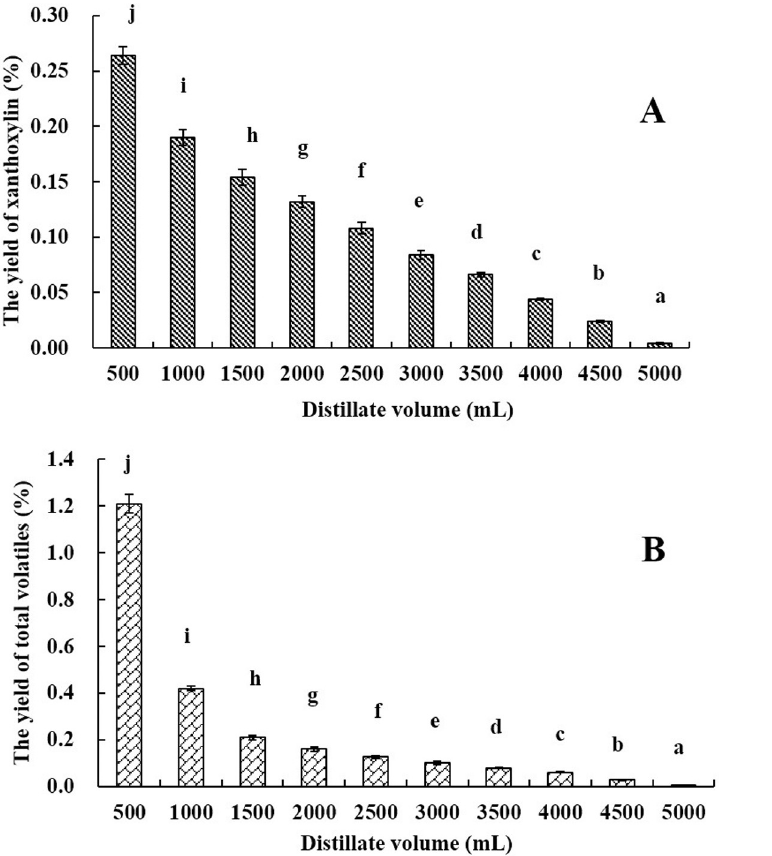
Fig 3. The yields of xanthoxylin (A) and total volatiles